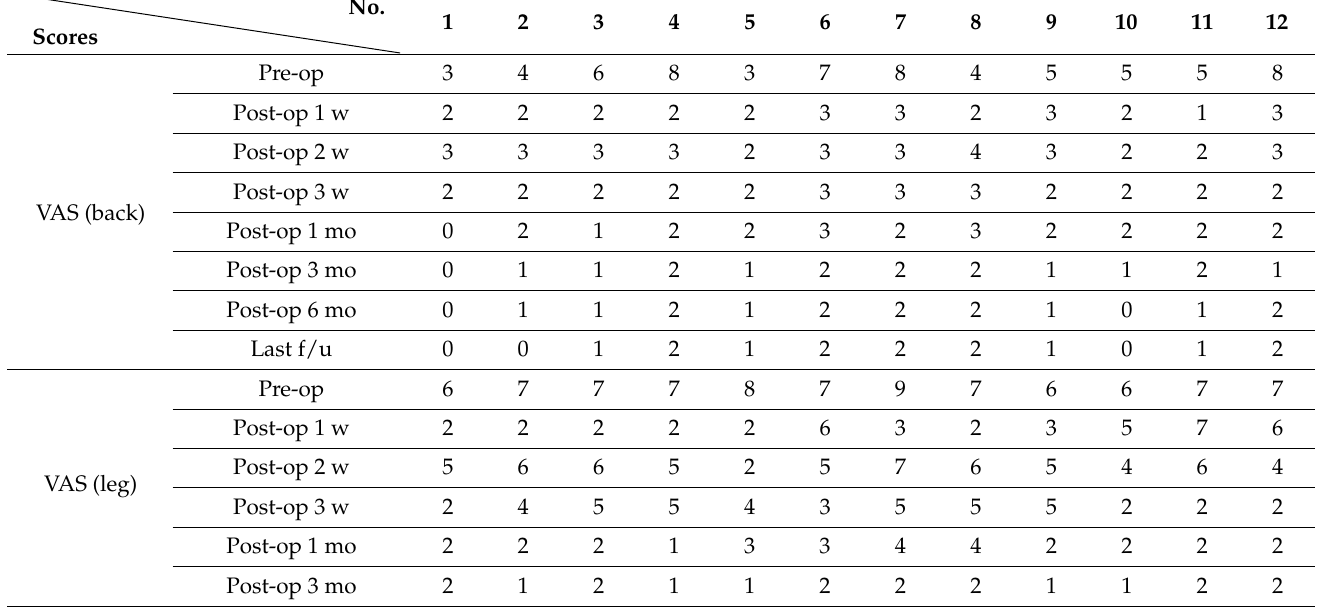
Table 3. Changes in VAS and ODI scores of rebound pain in patients with